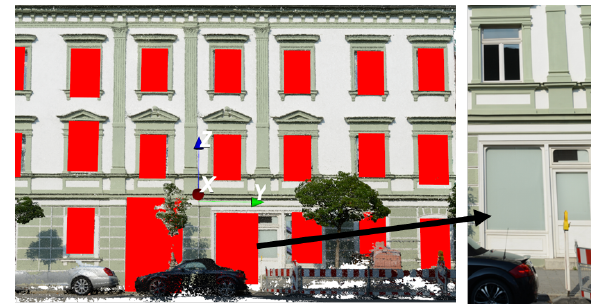
Figure 10: Two top left windows are not localized. This is because these windows are too close the neighbouring windows and their hypothesis overlaps these neighbouring windows and gets vote out due to the overlap. In general, we can remedy such problems by allowing many more samples that would increase the probabil- ity of getting a global maximum, i.e., in this case getting exactly two non-overlapping but very close windows.